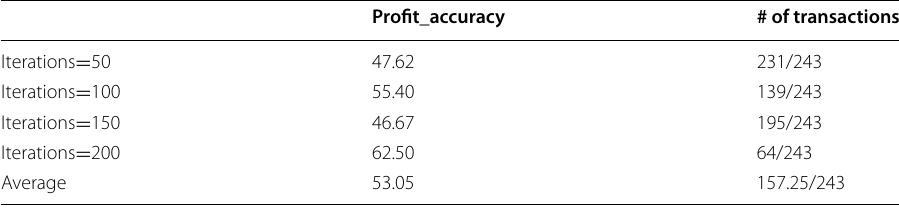
Table 6 ME_TI_LSTM model: one‑day‑ahead result summary